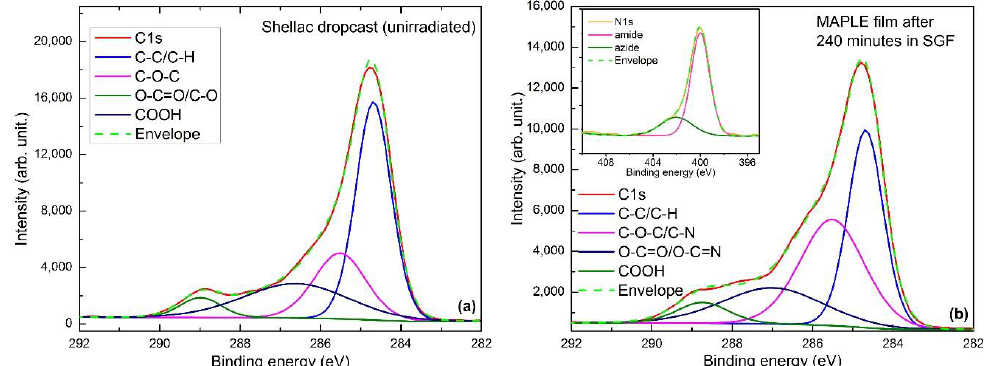
Figure 7. High resolution C 1 s and fitting for non-irradiated shellac ( a ) and for a sample immersed in gastric fluid for 240 min ( b ).